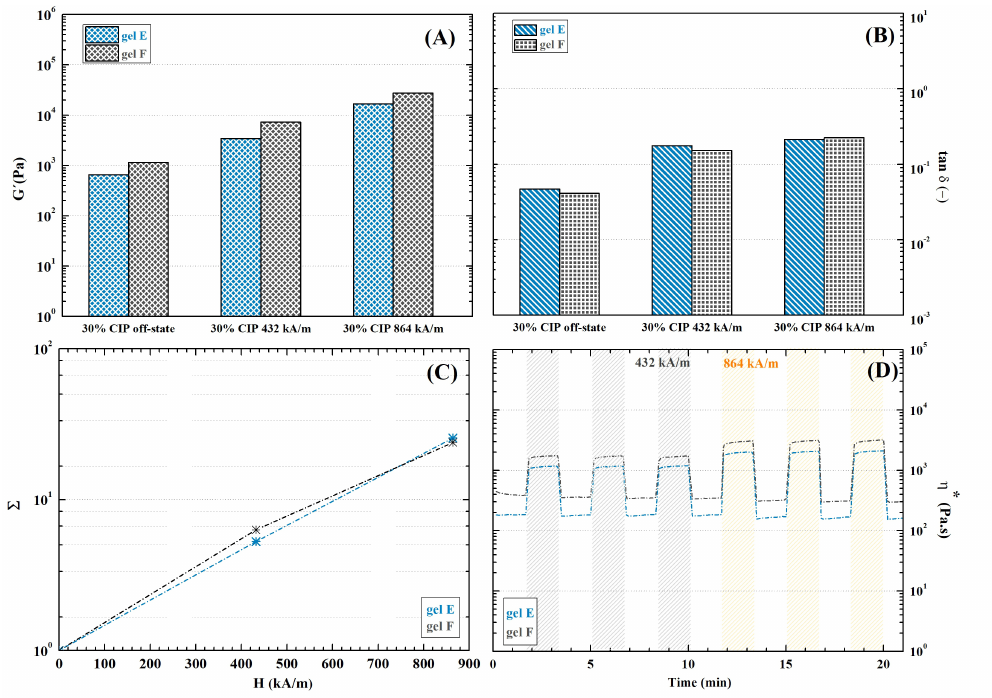
Figure 14. Mechanical characteristics obtained from rheological measurements of CIP-filled dually cross-linked hydrogels in an external magnetic field: ( A ) storage modulus; ( B ) damping factor; ( C ) intensity of MRE expressed as increase in storage modulus related to magnetic field intensity; ( D ) cyclic magnetic field